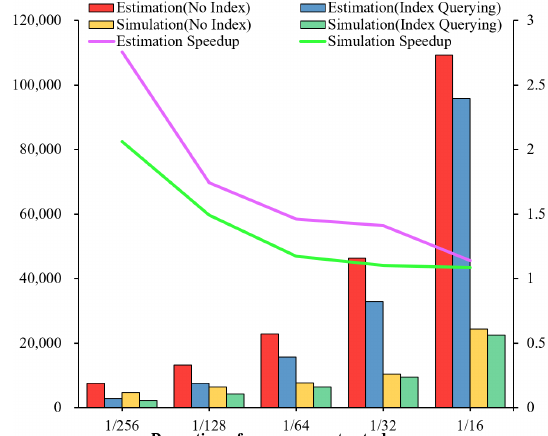
Figure 7. Performance comparison of cross K function with and without spatiotemporal index under increasing query scopes